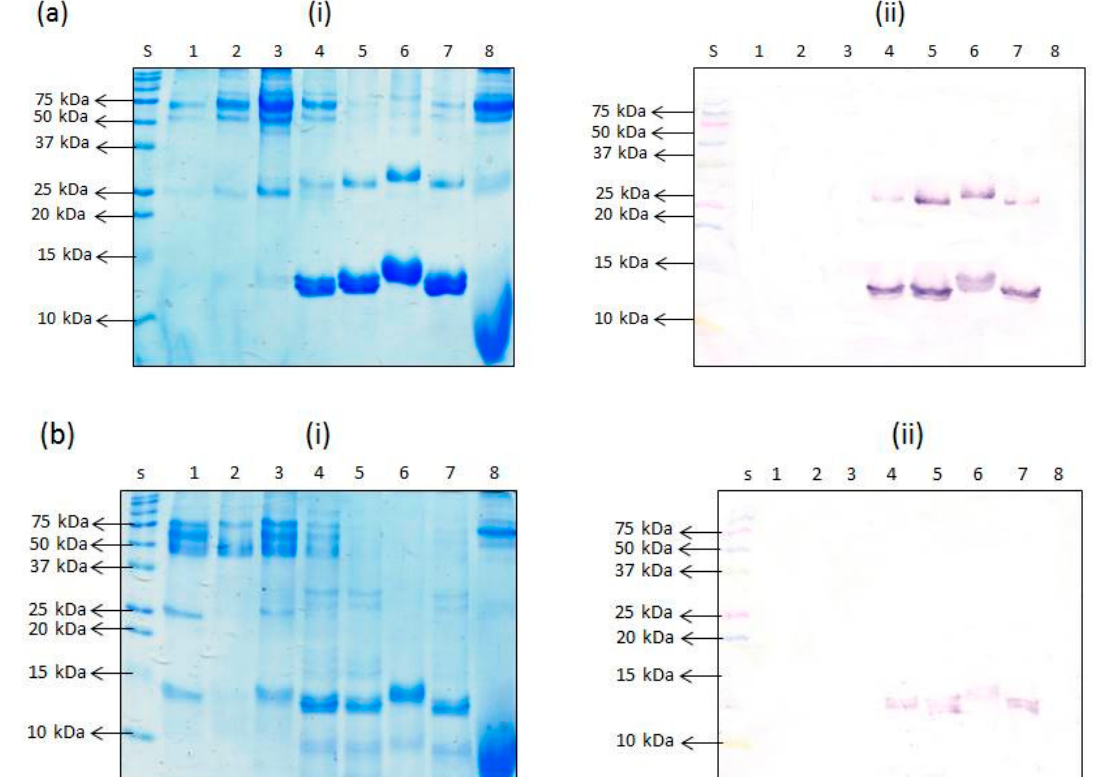
Figure 5. SDS PAGE ( i ) and western blot ( ii ) analysis of non-heated ( a ) and heated ( b ) extracts of porcine blood-derived proteins. Protein extracts were loaded at 10 µ g per 10 µ L of sample buffer per lane alongside Precision Plus Protein kaleidoscope pre-stained standards. Lane s: Precision Plus Protein Kaleidoscope standards; Lane 1: porcine plasma powder (PPP); Lane 2: porcine Fibrimex ® powder (PFP); Lane 3: Apropork (APP); Lane 4: Aprosan (APS); Lane 5: porcine hemoglobin powder (PHP); Lane 6: Aprored (APR); Lane 7: Aprothem (APT); and Lane 8: porcine hydrolyzed globin (PHG).